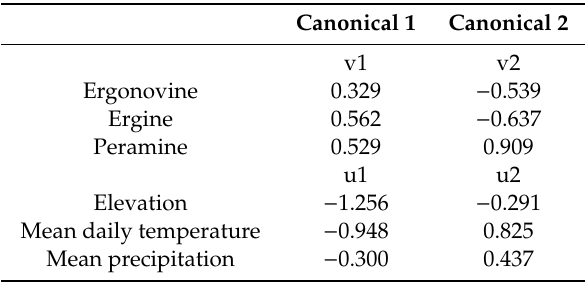
Table 4. Canonical coe ffi cients for derivation of canonical variates from standardized data.